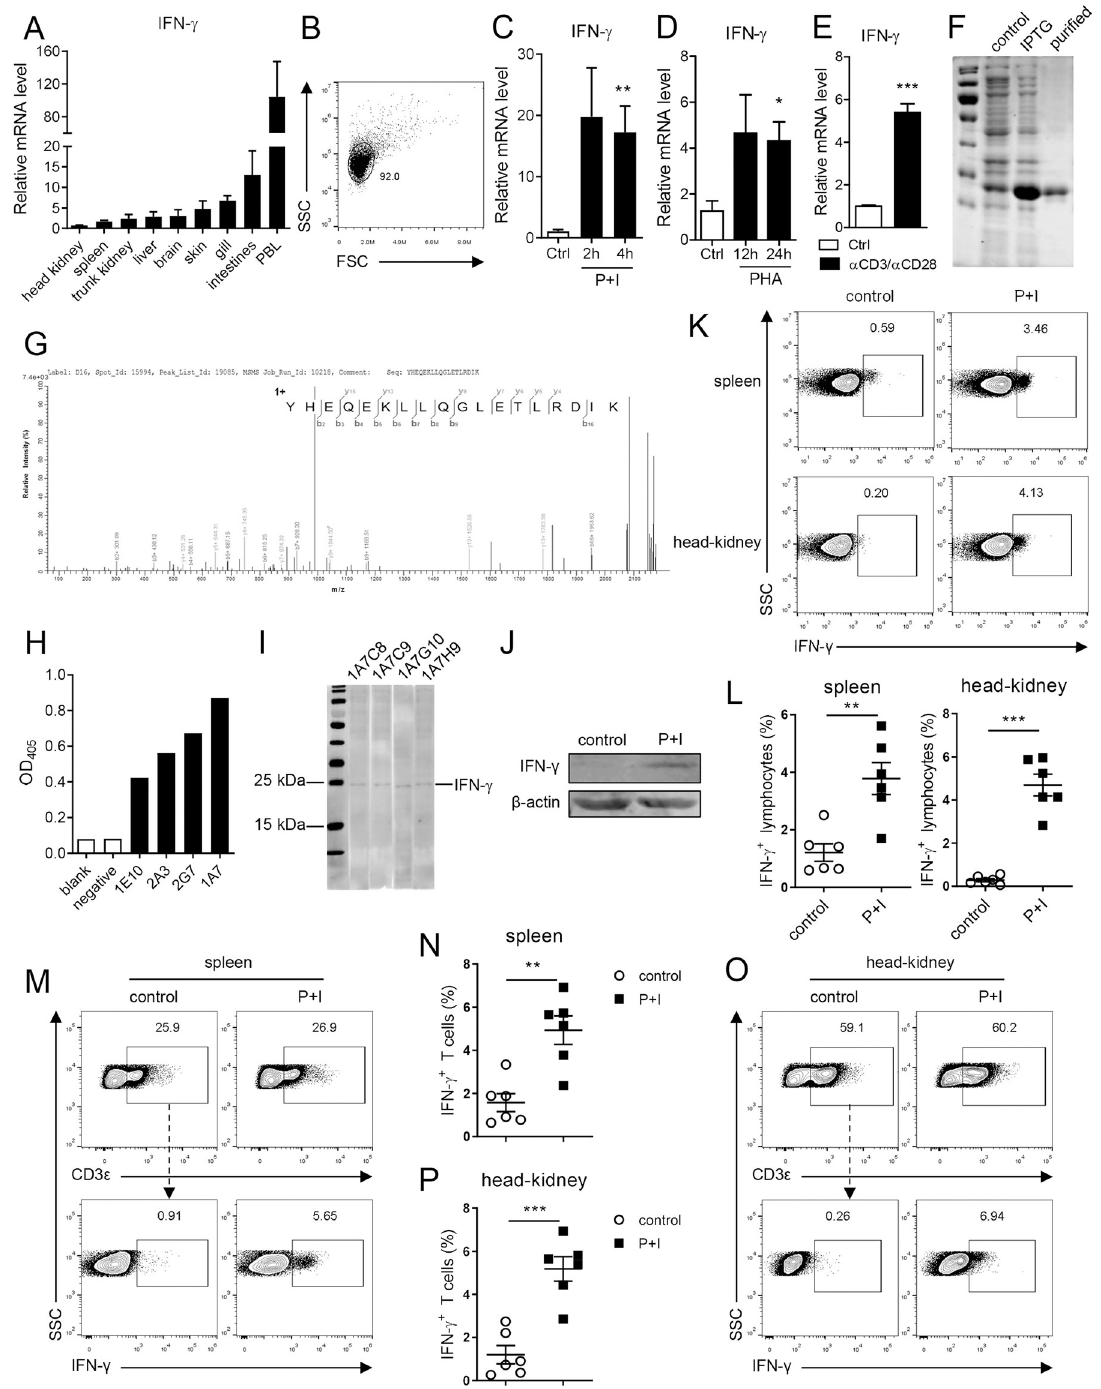
Fig 1. Tilapia T cells produce IFN- γ . ( A ) The expression of IFN- γ in different tissues was examined by qPCR, n = 5. ( B ) Flow cytometry analyzed the FSC/SSC profiles of spleen leukocytes and the gate represents lymphocytes. ( C - E )Spleen leukocytes were stimulated with PMA plus ionomycin (P+I) ( C ), PHA ( D ) or α -CD3 ε / α -CD28( E ), and relative mRNA levels of IFN- γ were examined by qPCR, n = 4–6. ( F ) SDS-PAGE assay of recombinant IFN- γ protein. ( G ) Maldi-TOF-TOF analysis of recombinant IFN- γ protein. ( H ) Candidate IFN- γ mAbs were screened by ELISA. ( I ) Western blot assay showed the binding of mAbs to overexpressed tilapia IFN- γ in HEK 293T cells. ( J-P ) Spleen or head kidney leukocytes were stimulated with P+I for 4 h in the presence of GolgiPlug. The expression of IFN- γ in leukocytes was detected by western blot ( J ) or flow cytometry ( K ), and the expression of IFN- γ in CD3 + T cells from spleen ( M ) and head kidney ( O ) were detected by flow cytometry. Scatter plot figures showed the percentages of IFN- γ in gated lymphocytes ( L ) or